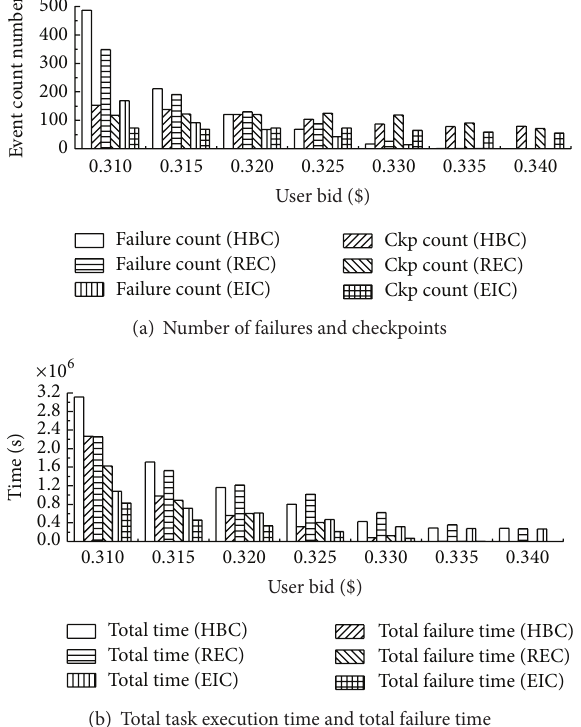
Figure 15: Performance comparison of checkpointing schemes according to user bid.